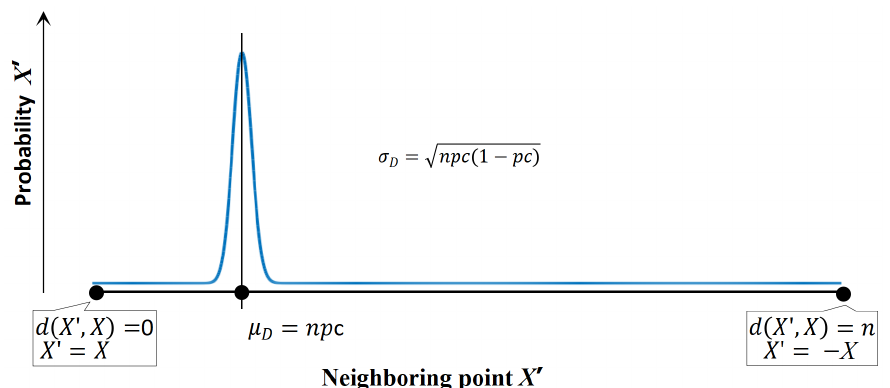
Figure 2. Distribution of X (cid:48) related to p . A neighboring point X (cid:48) having distance npc has a high probability of appearing.